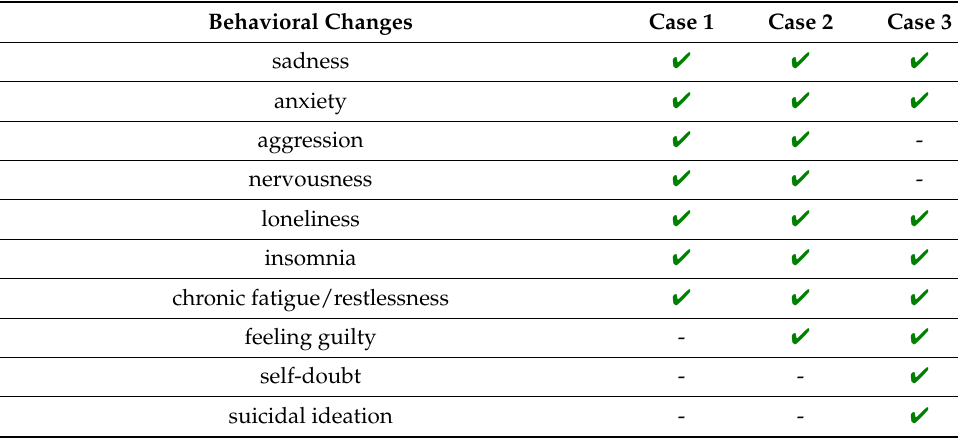
Table 3. The most important behavioral changes noted after the psychological autopsy